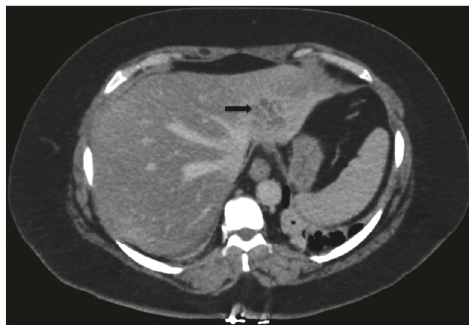
Figure 3: Low-power view of the interface between an endometri- otic nodule and liver parenchyma. Notice the large endometrial type glands surrounded by endometrial type stroma in the superior portion of the image. These are separated from the liver parenchyma (lower right portion) by a band of fibrosis. The liver parenchyma displays macrovesicular steatosis. Hematoxylin & Eosin, 40x.